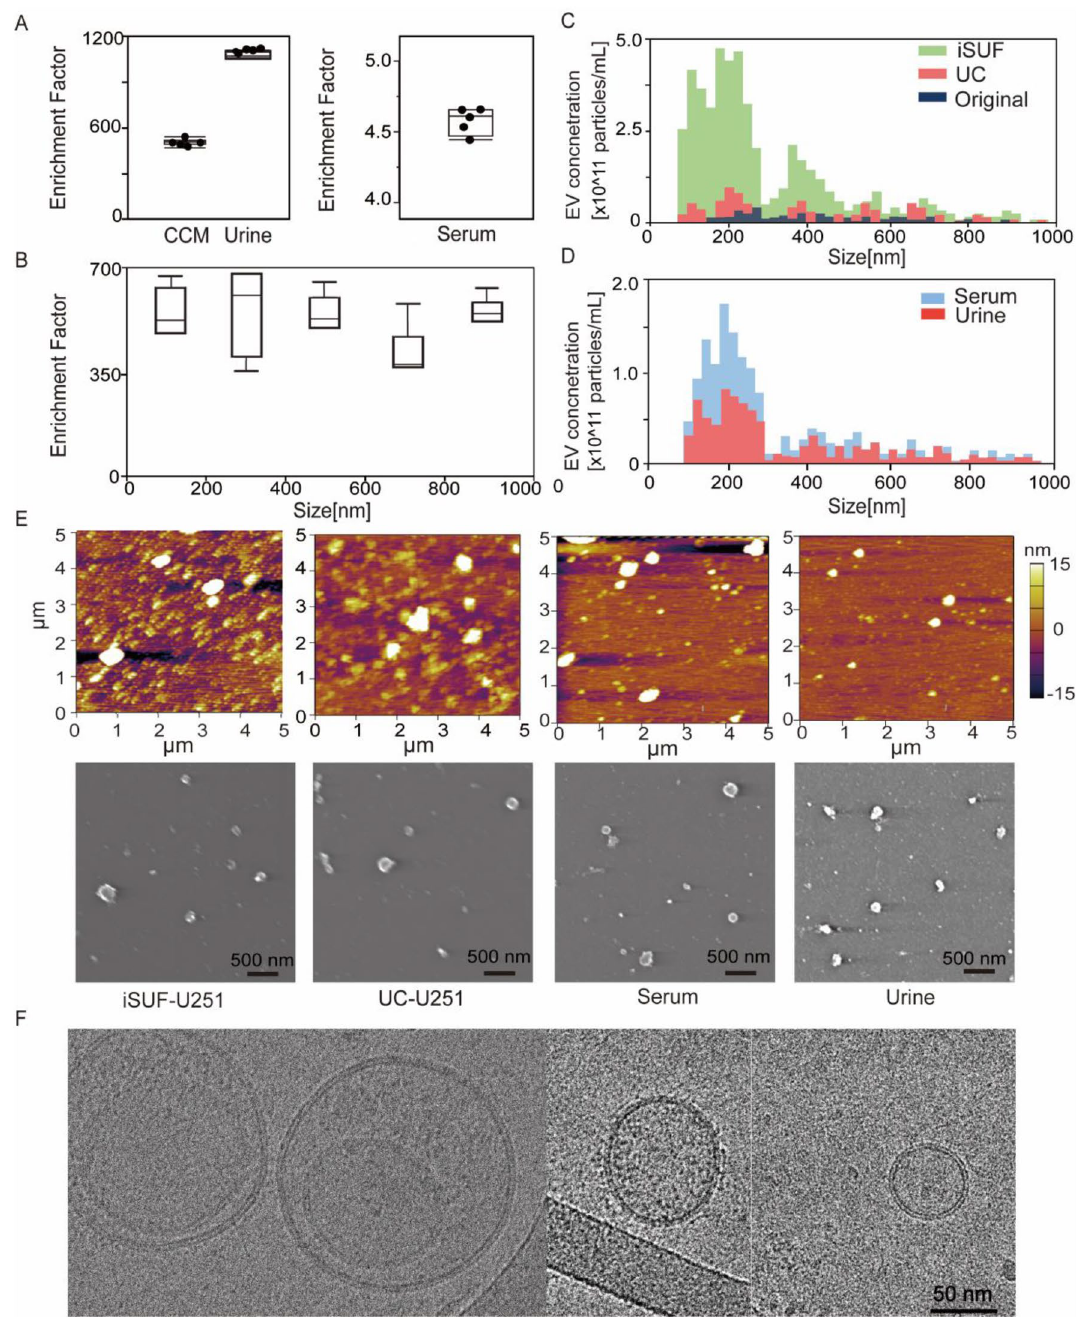
Figure 2. iSUF enrichment performance and characterization of EVs separated from CCM, serum and urine using iSUF. ( A ) Enrichment factor (EF) for EVs present in CCM, urine, and serum after iSUF (n = 5 for each biofluid; p > 0.05) (mean ± STD). Enrichment factors (EFs) were calculated as the ratio of EV concentration in biofluids present before and after iSUF processing. CCM was processed for U-251, MCF-7 and A375 cell lines. ( B ) EFs for different size ranges of EVs for CCM (n = 3; p > 0.05) (mean ± STD). ( C ) qNano measurements of the size distribution and concentration of EVs in the original CCM, after iSUF processing, and after UC processing. The EV concentration after iSUF was significantly higher than in the original CCM and after UC processing (n = 3; p < 0.05) (mean ± STD). ( D ) qNano measurements of the size distribution and concentration of EVs in serum and urine after iSUF processing. ( E ) AFM and SEM images of EVs from U251 CCM after iSUF processing and UC processing. Images were also obtained for EVs in serum and urine after iSUF processing. ( F ) Transmission-EM images of EVs present in CCM after iSUF